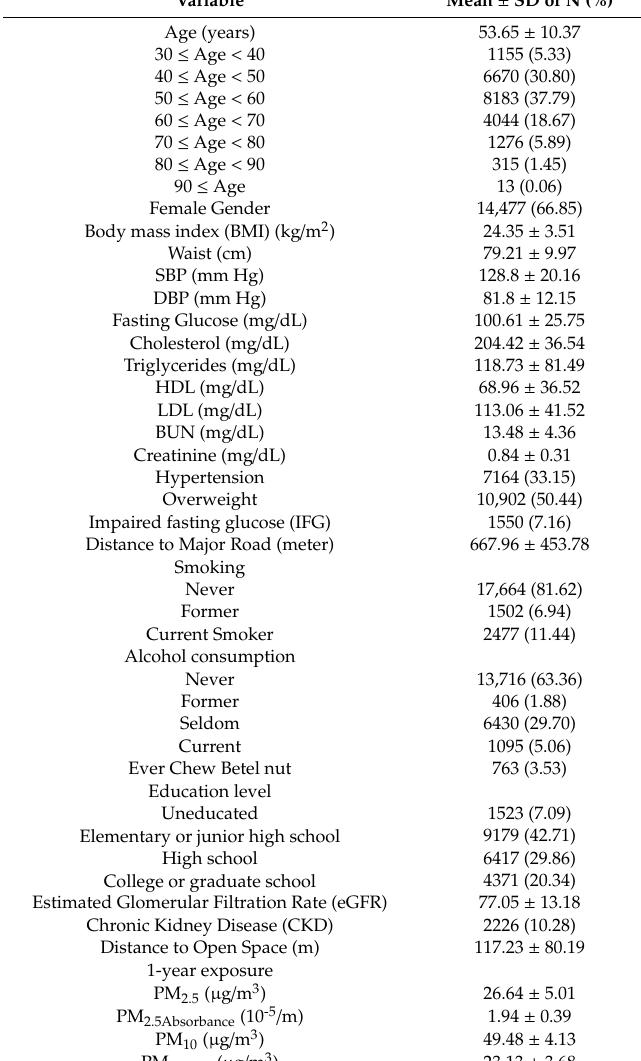
Table 1. Characteristics of the 21,656